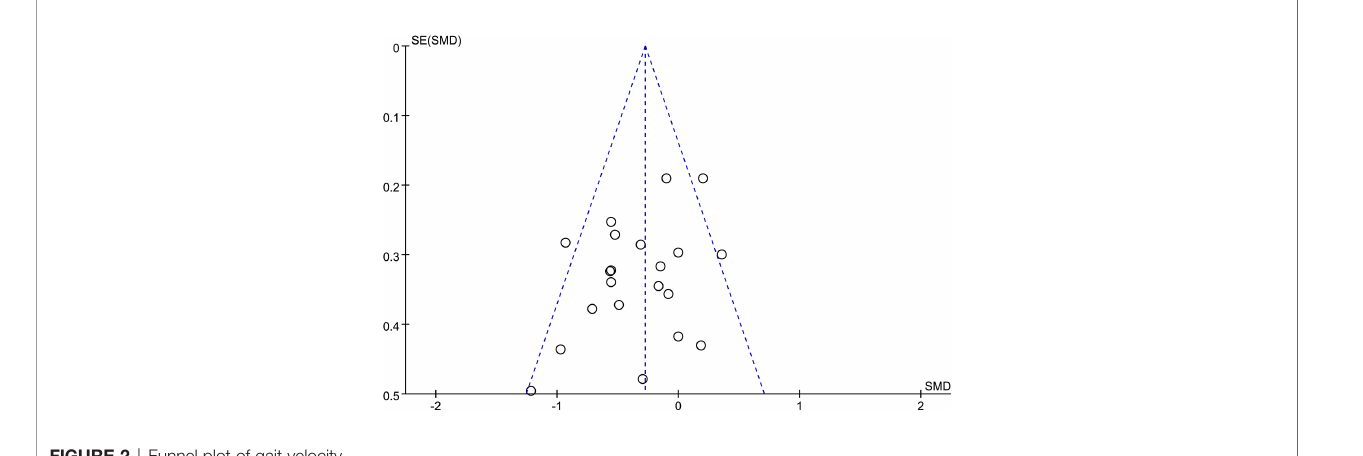
FIGURE 2 | Funnel plot of gait velocity.